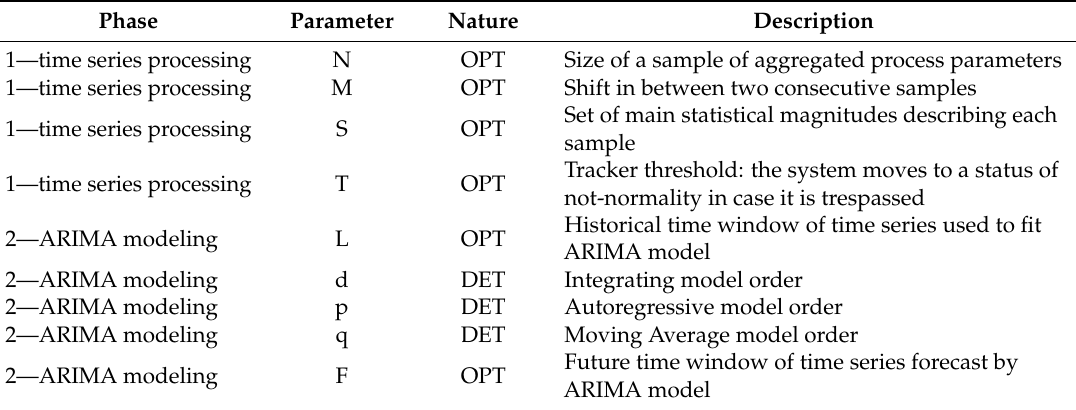
Table 1. Parameters to be tuned in the two macro-stages of the proposed procedure to optimize algorithm’s performances. DET parameters are determined “a priori” by the algorithm itself, while OPT parameters are tuned, starting from a reasonable first attempt value, through a SA procedure. Phase Parameter Nature